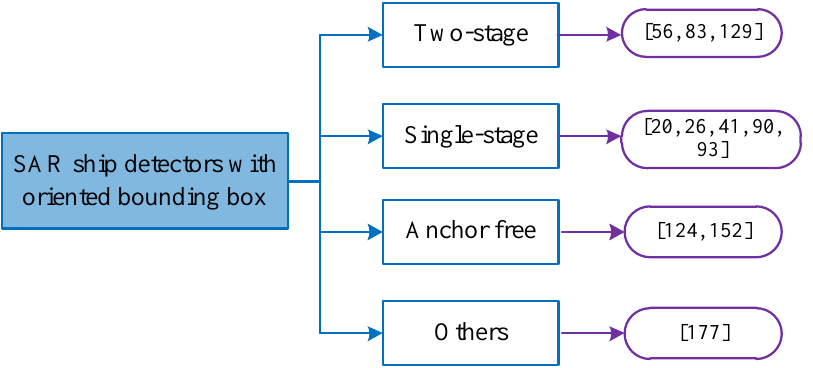
Figure 11. The SAR ship detectors with oriented bounding box.